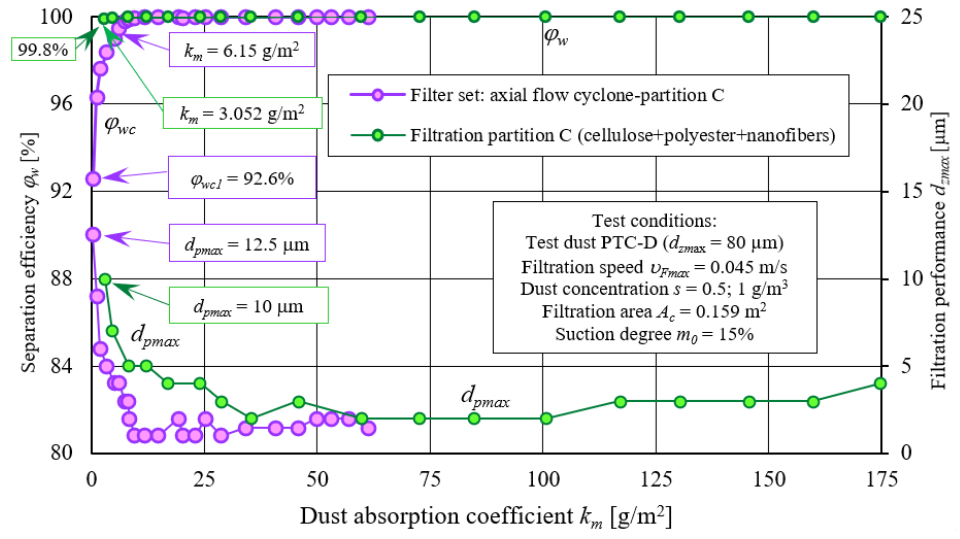
Figure 15. Characteristics: separation efficiency φ w = f ( k m ) and filtration performance d pmax = f ( k m ) as a function of the dust absorption coefficient k m of filter material C working in the “filter set” as the second filtration stage (after through cyclone) and in single ‐ stage system—no cyclone.